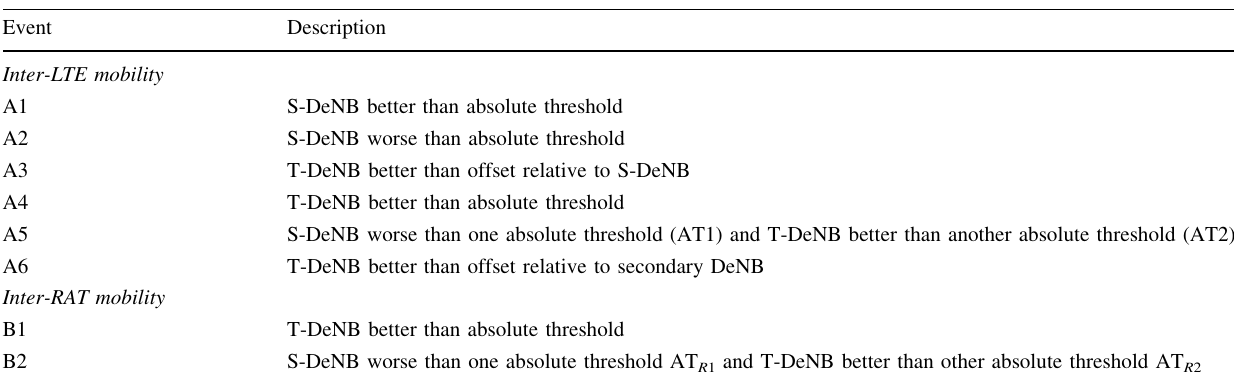
Table 1 Event triggers for measurement